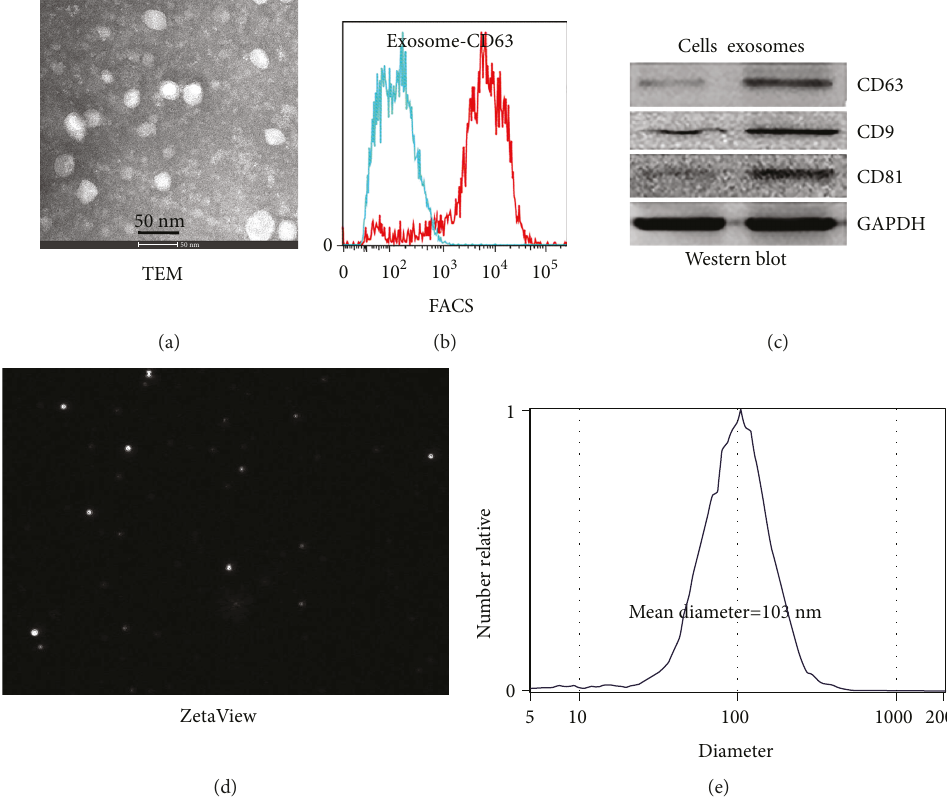
Figure 1: Characterization of hAEC-Exos. (a) TEM image of hAEC-Exos ( n = 5 ). (b) Flow cytometry analysis of exosomal marker CD63 ( n = 4 ). (c) Western blot analysis of exosomal markers CD63, CD9, and CD81 ( n = 3 ). (d) ZetaView analysis of hAEC-Exos ( n = 3 ). (e) Size distribution of hAEC-Exos (mean diameter =103nm, n = 3